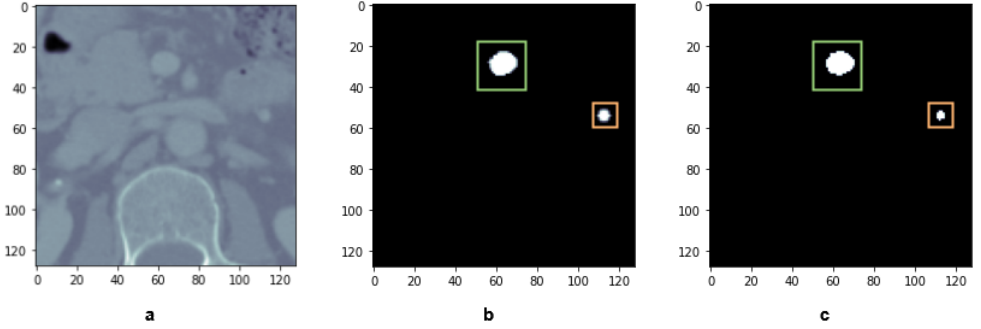
Figure 10. Portal vein sample 3: image ( a ), original mask ( b ) and predicted mask ( c ) after pre- processing with zoom.